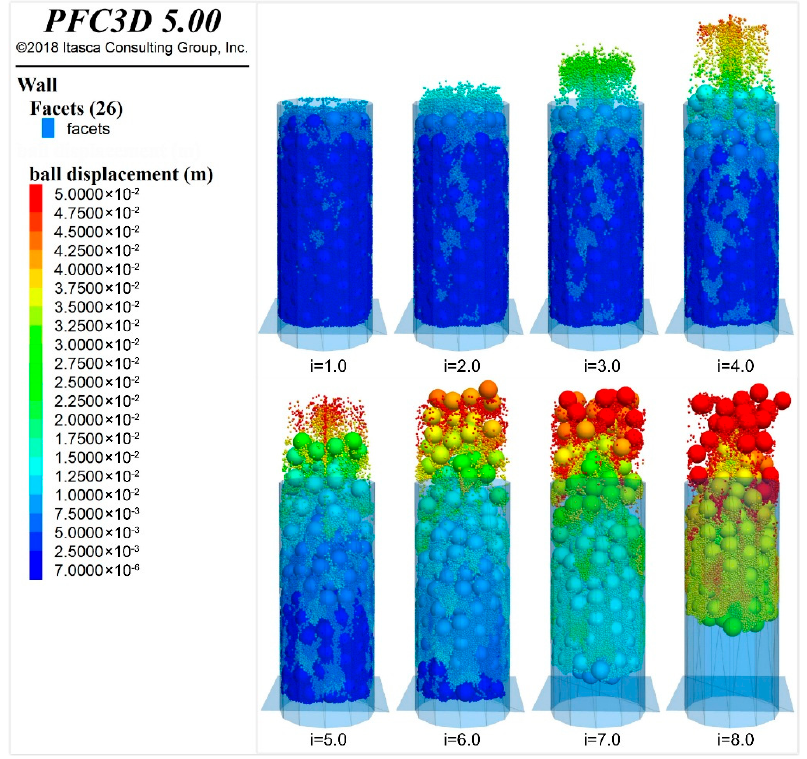
Figure 15. Movement of particles under different hydraulic gradients.